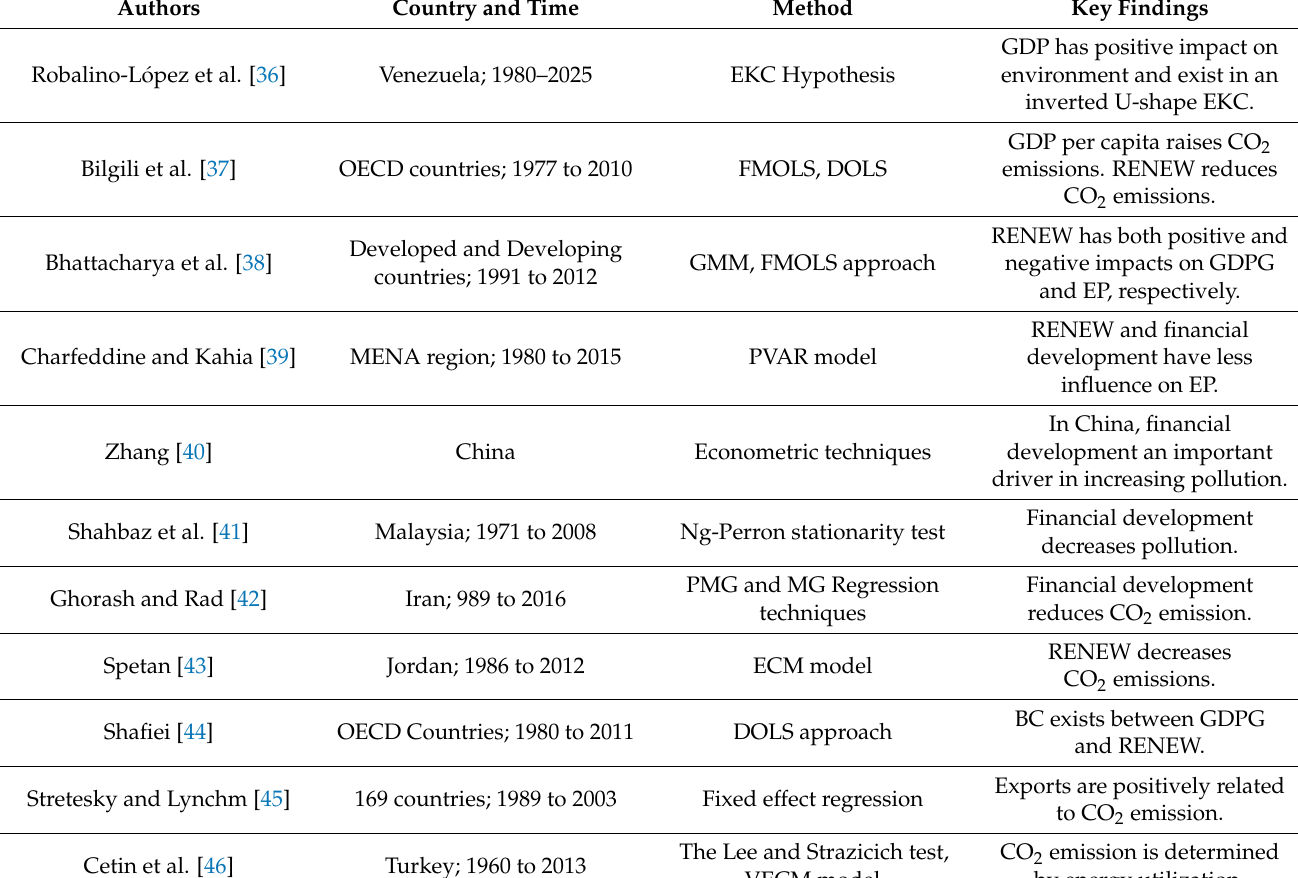
Table 1. Summary of Relevant